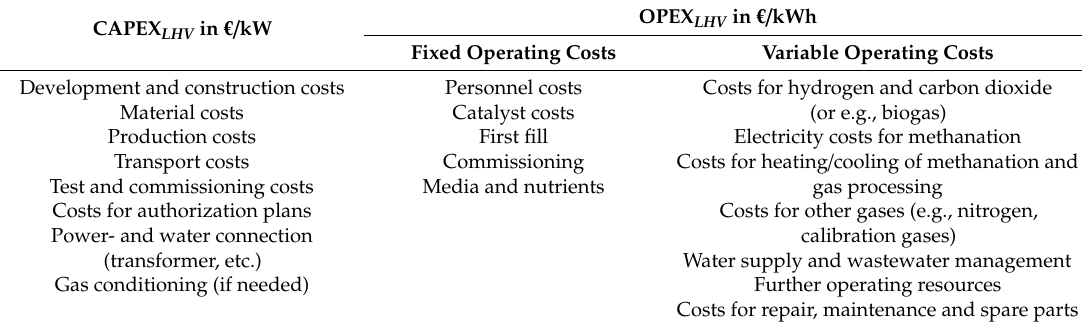
Table 7. CAPEX and OPEX cost parameters for the biological CO 2 -Methanation